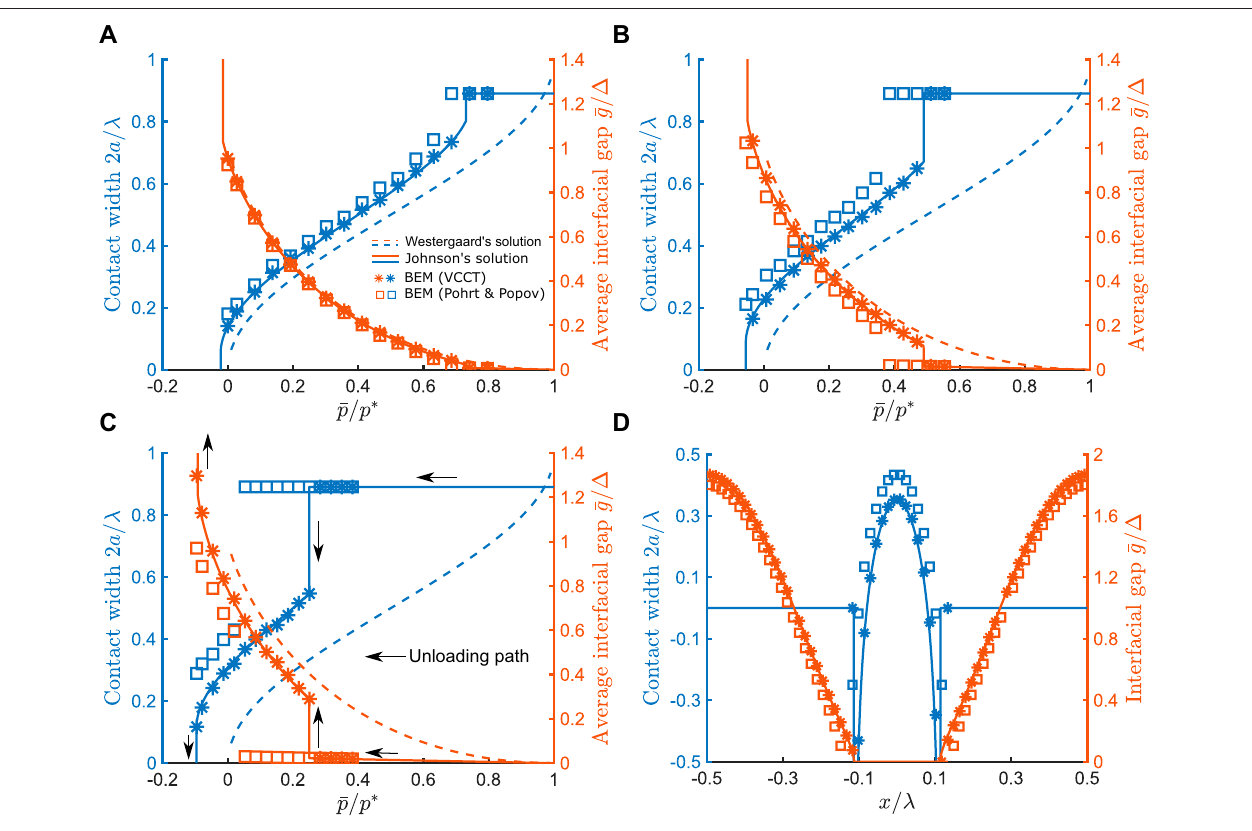
FIGURE 8 | Dimensionless contact radius 2 a ( (cid:1) p ) / λ and dimensionless average interfacial gap (cid:1) g ( (cid:1) p ) / Δ associated with (A) α (cid:1) 0.1; (B) α (cid:1) 0.2; (C) α (cid:1) 0.3; (D) dimensionless contact pressure p ( x )/ p *, and dimensionless interfacial gap g ( x )/ Δ where (cid:1) p / p * (cid:1) 0 (MPa), α (cid:1) 0.2, E * (cid:1) 1 (MPa), λ (cid:1) 10 (mm), Δ (cid:1) 0.1 (mm), n x (cid:1) n y (cid:1) 128, computational domain size (cid:1) λ × λ